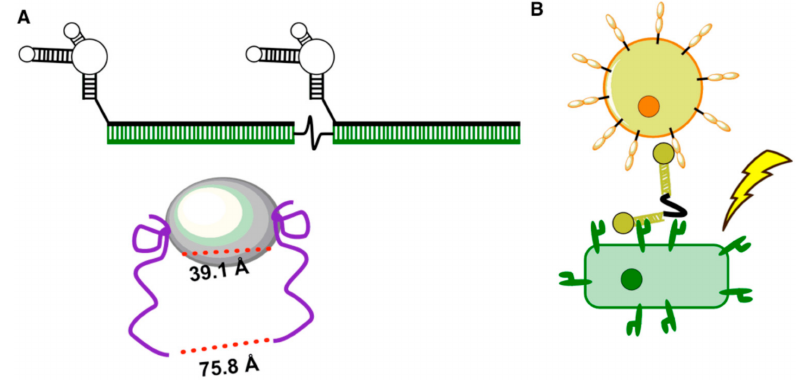
Figure 3. Engineered aptamers to modulate interactions in the immune system. ( A ) Bivalent aptamers were designed to modulate OX-40 receptors expressed in murine T cells. A polyethylene spacer was employed between the aptamers to enhance free rotation of the aptamers to enhance cross-linking [69]. The bivalent aptamers were designed to match the space between the two OX receptor (cid:48) s natural ligand binding sites; ( B ) design of bispecific aptamers to modulate interactions in the immune system [68]. immunotherapeutics